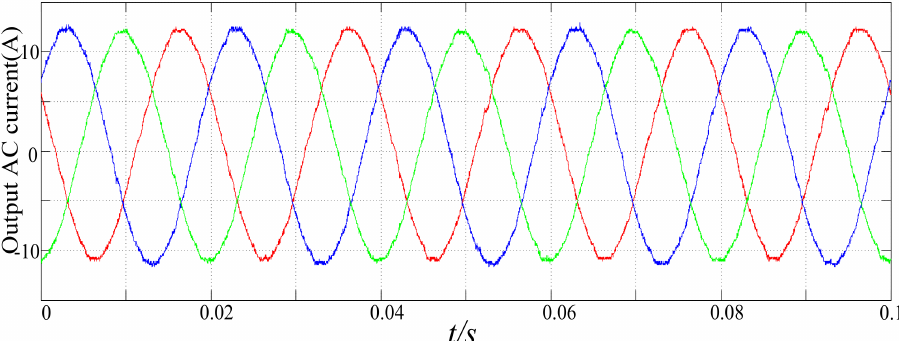
Figure 15. The experiment result of the AC output current.